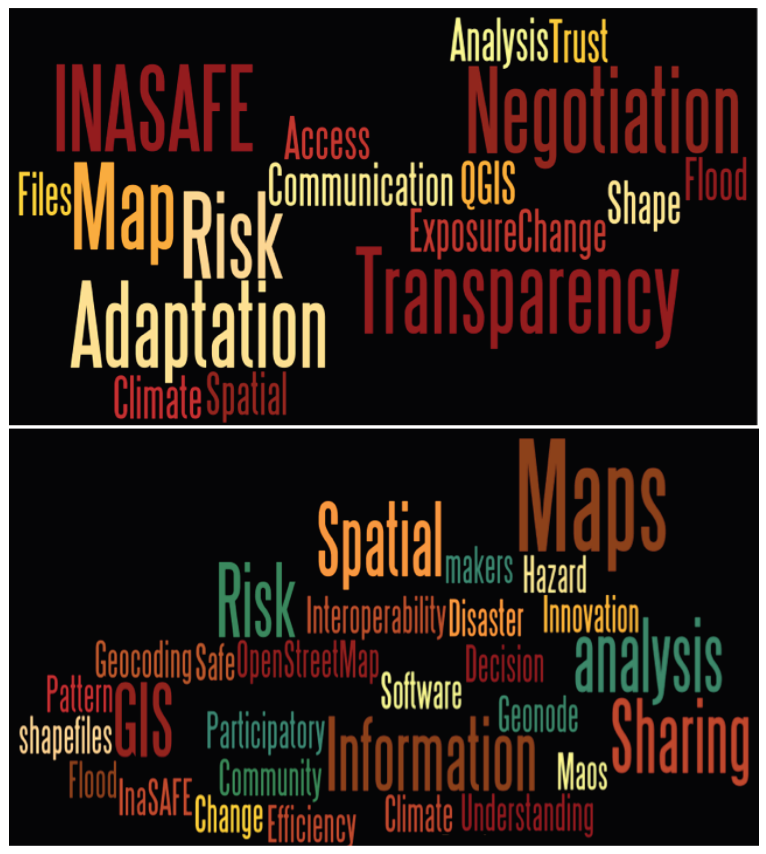
Figure 6. Examples of wordcoulds emerging from the game “Snap!”, illustrating concepts that players associated with Open Data for Resilience after and before the participatory training